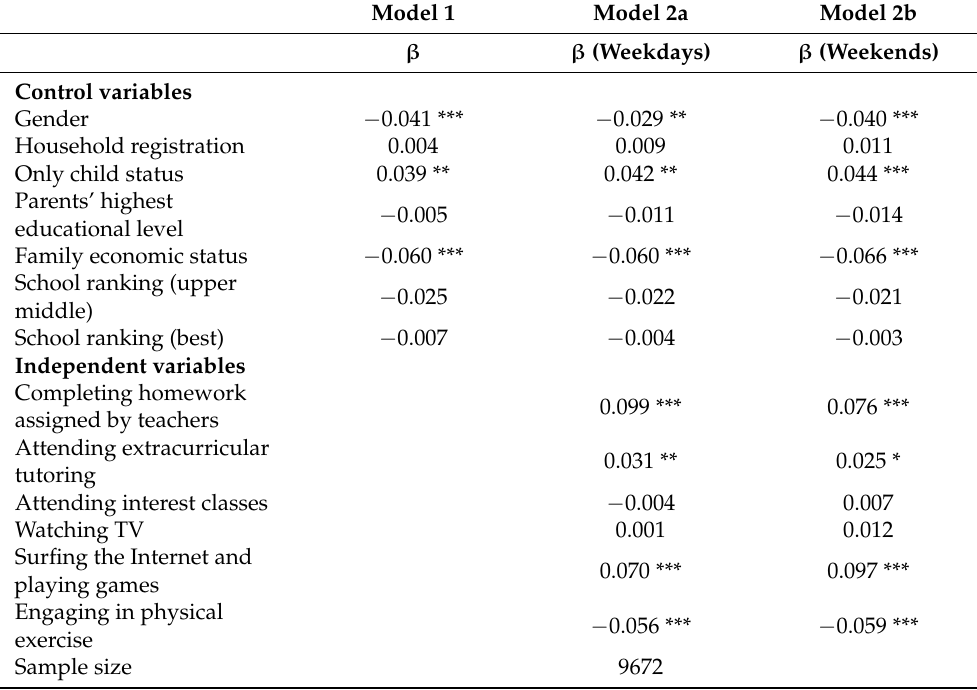
Table 3. Effects of extracurricular activities on depressive